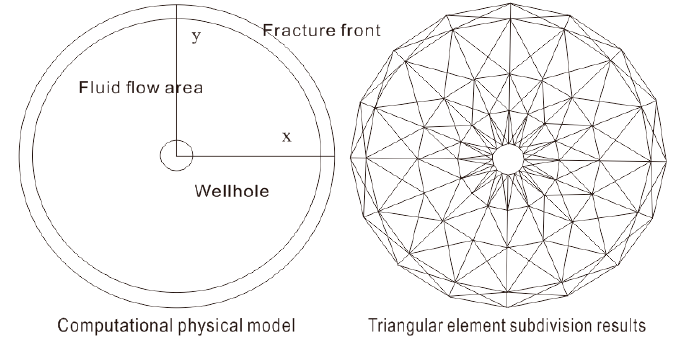
Figure 1. Quasi-three-dimensional fracture geometry.